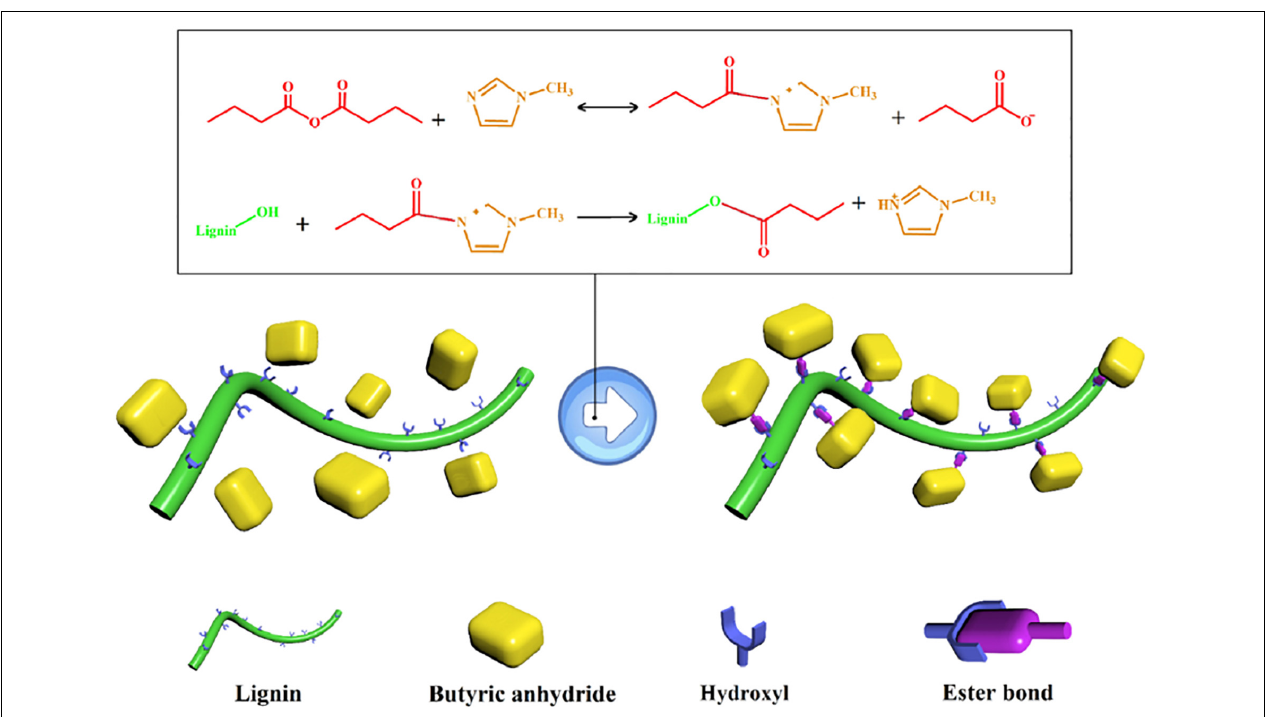
FIGURE 6 | Illustration diagram of lignin esterification reaction (Dai Z. et al.,